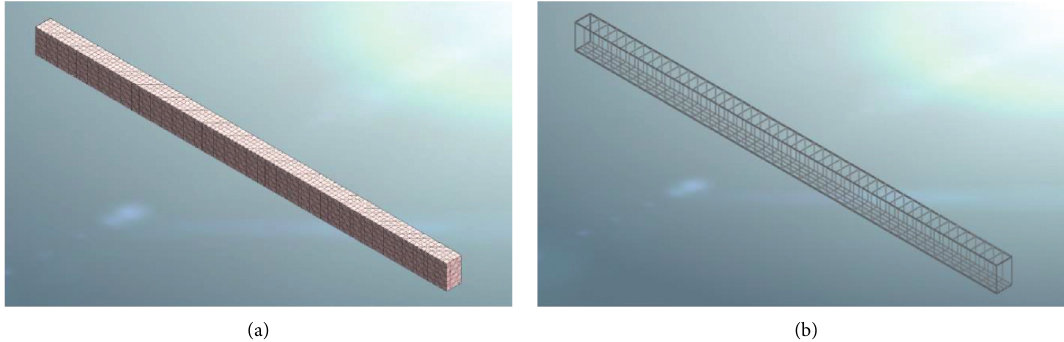
Figure 16: Geometrical modelling and FE resolution: (a) concrete and (b) internal reinforcement.